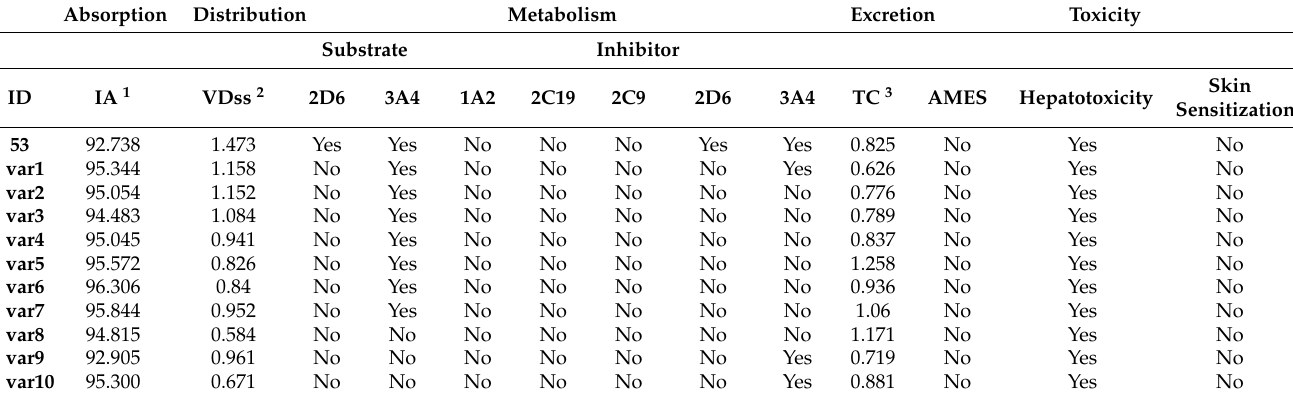
Table 5. Absorption, distribution, metabolism, excretion, and toxicity (ADMET) properties of new designed molecules. Absorption Distribution Metabolism